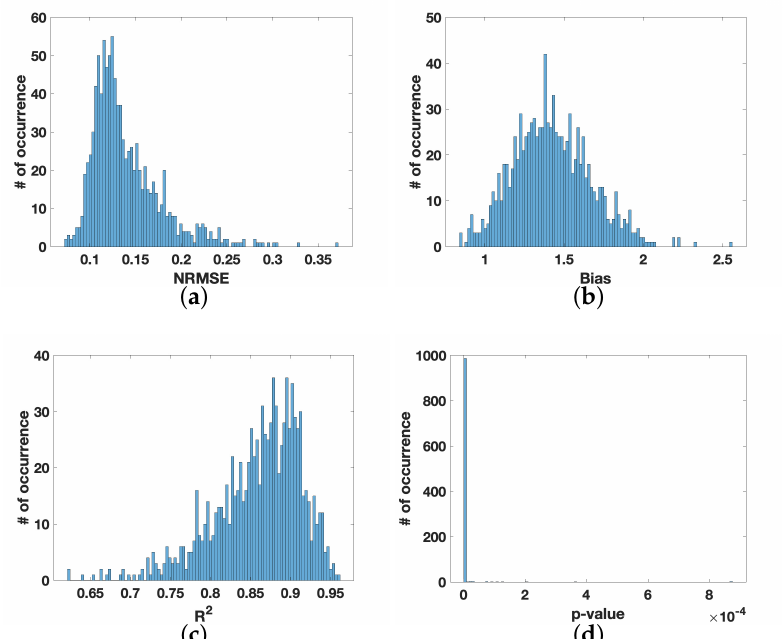
Figure 6. Results of the cross validation for the computed statistical measures for 1000 iterations of the merged Arctic and COASTlOOC datasets: the NRMSE ( a ), Bias ( b ), R 2 ( c ) and p-value ( d ).